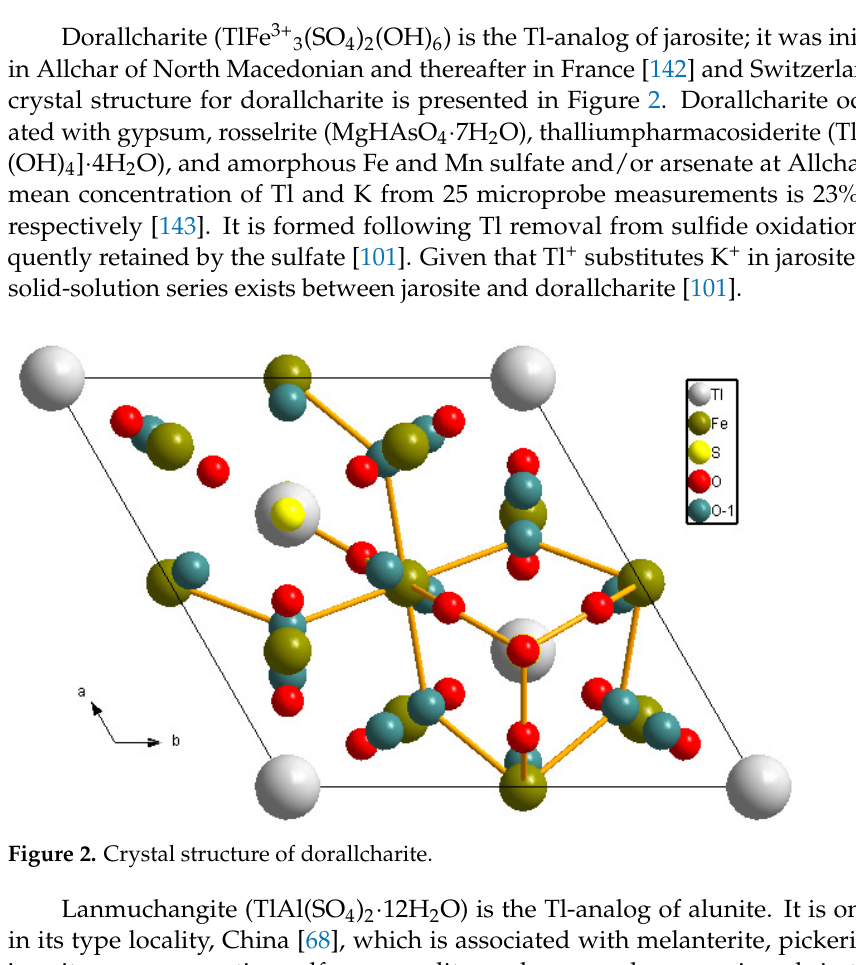
Figure 3. Crystal structure of Lanmuchangite.